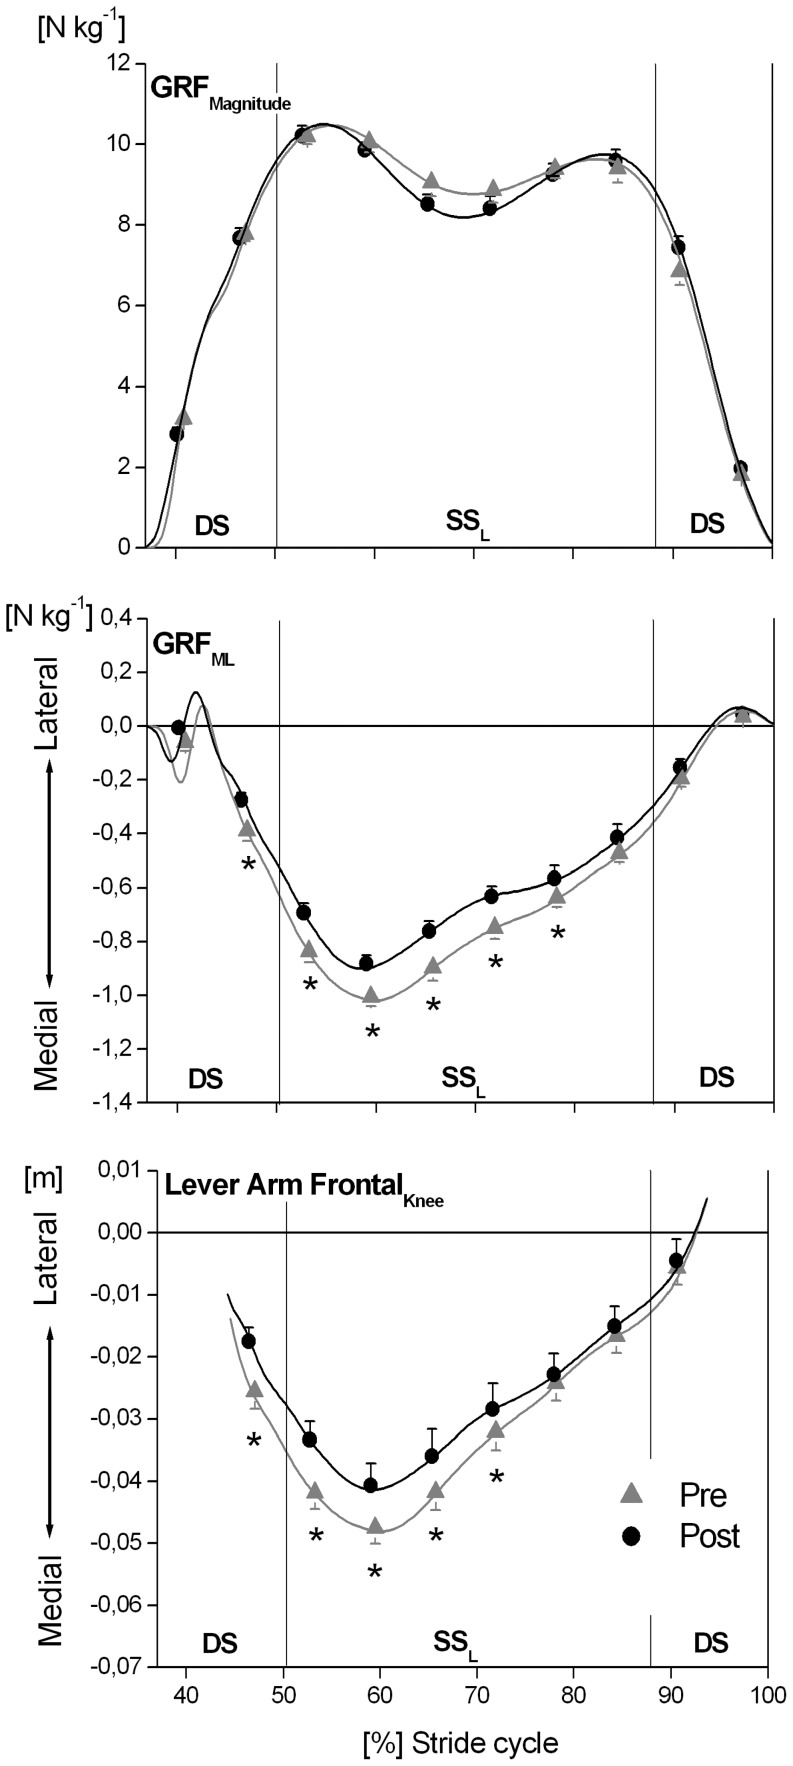
Magnitude of the ground reaction force vector (GRFMagnitude), mediolateral component of the GRF (GRFML) and lever arm of the GRF acting about the knee joint at the frontal plane (Lever Arm FrontalKnee) while incline walking determined before (pre) and after (post) the triceps surae and quadriceps femoris muscle-tendon unit exercise-intervention (means and SE).The x-axis was normalized from 0 to 100% of a stride cycle. The vertical solid lines represent the instants of touchdown (TD) and take off (TO) of the left and right foot. DS: double support phase; SSL: single support phase of the analyzed left leg. Lateral-medial Lever Arm FrontalKnee refers to the position of the line of action of the GRF relative to the knee joint centre. Lever Arm FrontalKnee was not determined for the first and last 10% of the support phase because of the low GRFs and the consequently unreliable calculation of Lever Arm FrontalKnee. *: Statistically significant differences between pre and post (P<0.05).